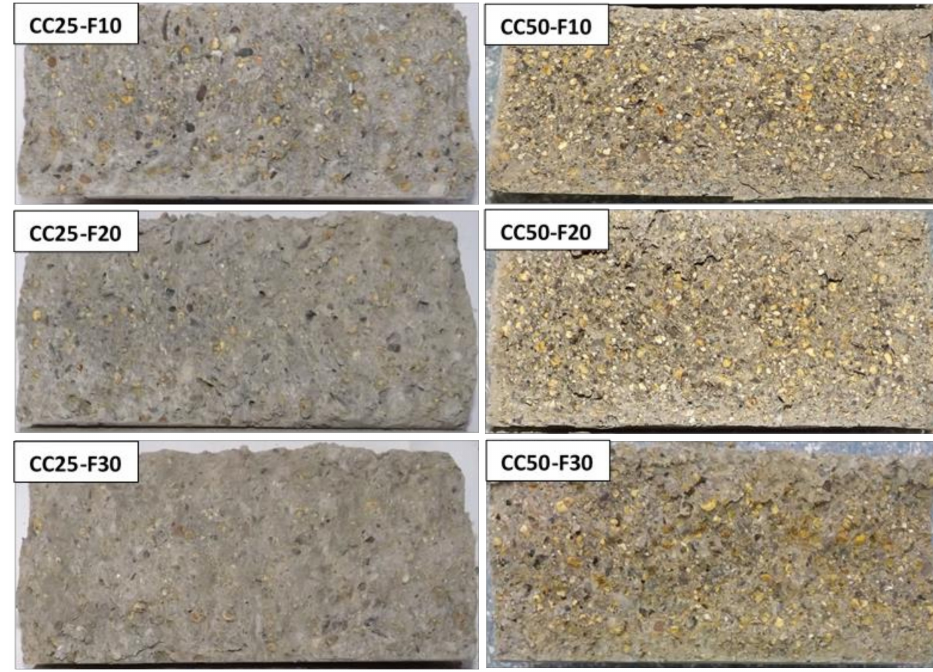
Figure 18. The cylinder’s section of CC-F group of composites, after splitting tensile testing. The splitting tensile strength of the analyzed compositions is shown in Figure 19. Fly ash in a rate of 10% decreased the splitting tensile strength of the RC by around 24%. In the case of CF20, an improvement in splitting tensile strength of up to 2.6% has been observed, than the previous variant with 10% fly ash. A surplus of another 10% fly ash (CF30) led to a decrease of this parameter by approximately 35 and 50% compared to CF20 and RC, respectively.